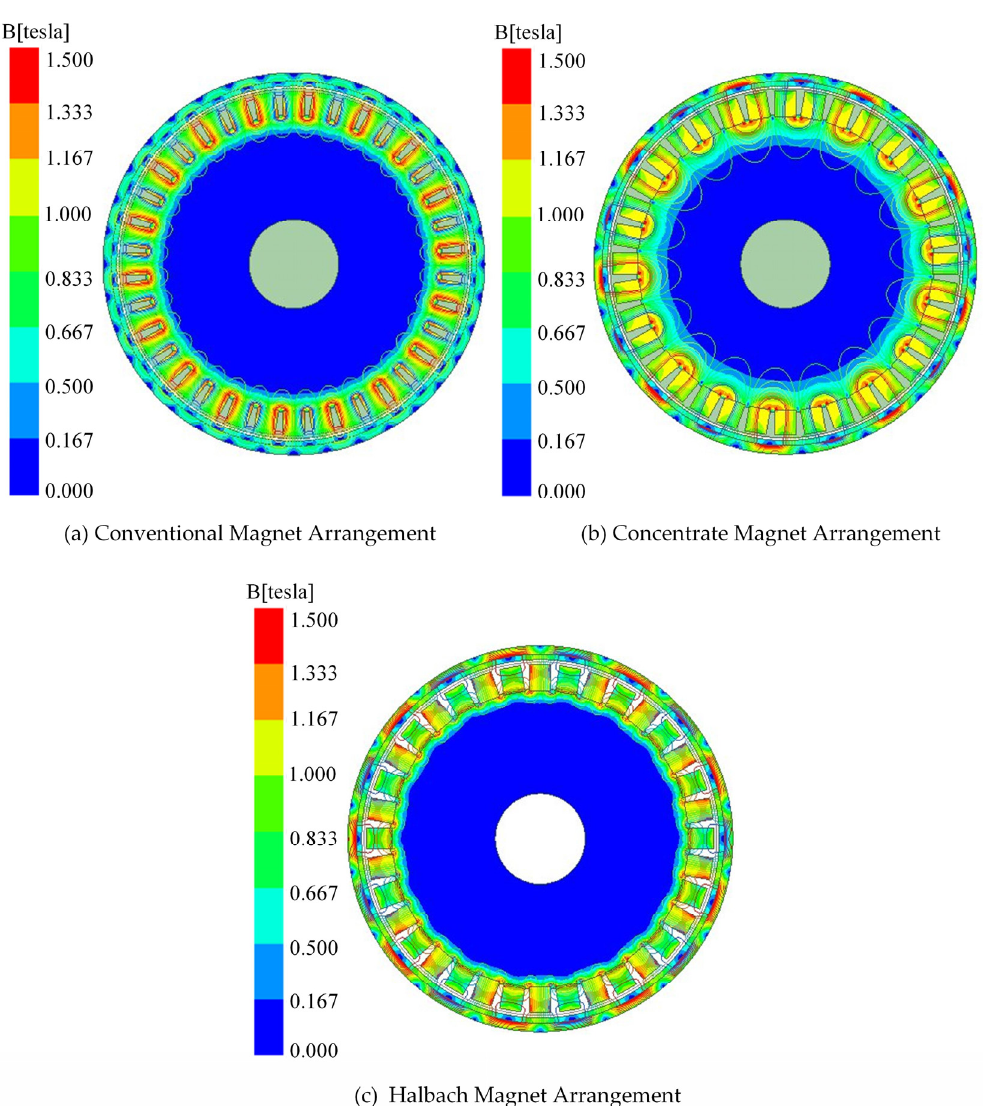
Figure 8. Magnetic flux density distribution in CPMG.